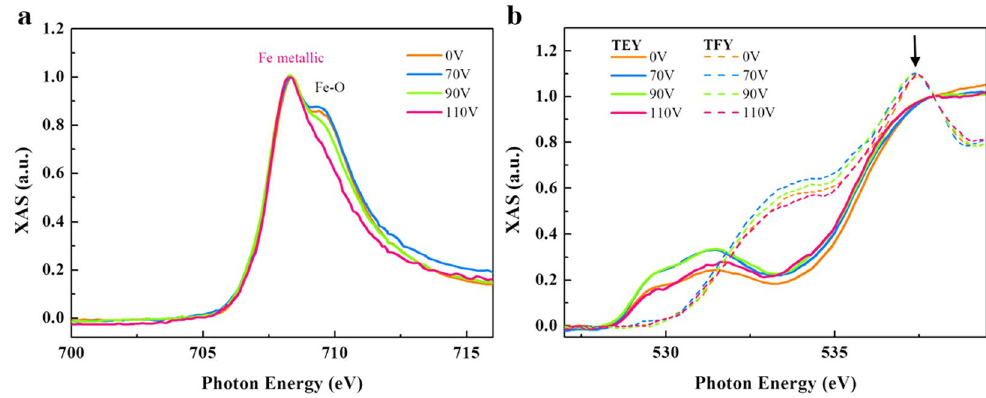
Figure 3. Voltage-dependent x-ray results. ( a ) Voltage-dependent Fe L 3 XAS with ex-situ treatment , collected by TEY mode. XAS peaks corresponding to Fe-metallic and Fe-O features are marked. ( b ) Voltage dependent O K -edge XAS with ex-situ treatment , collected by TEY (solid lines) and TFY (dashed lines) modes. Arrow indicates Fe-O hybridization with an O termination of the ZnO layer adjacent to the Fe layer. All the XAS spectra have been normalized to the absorption